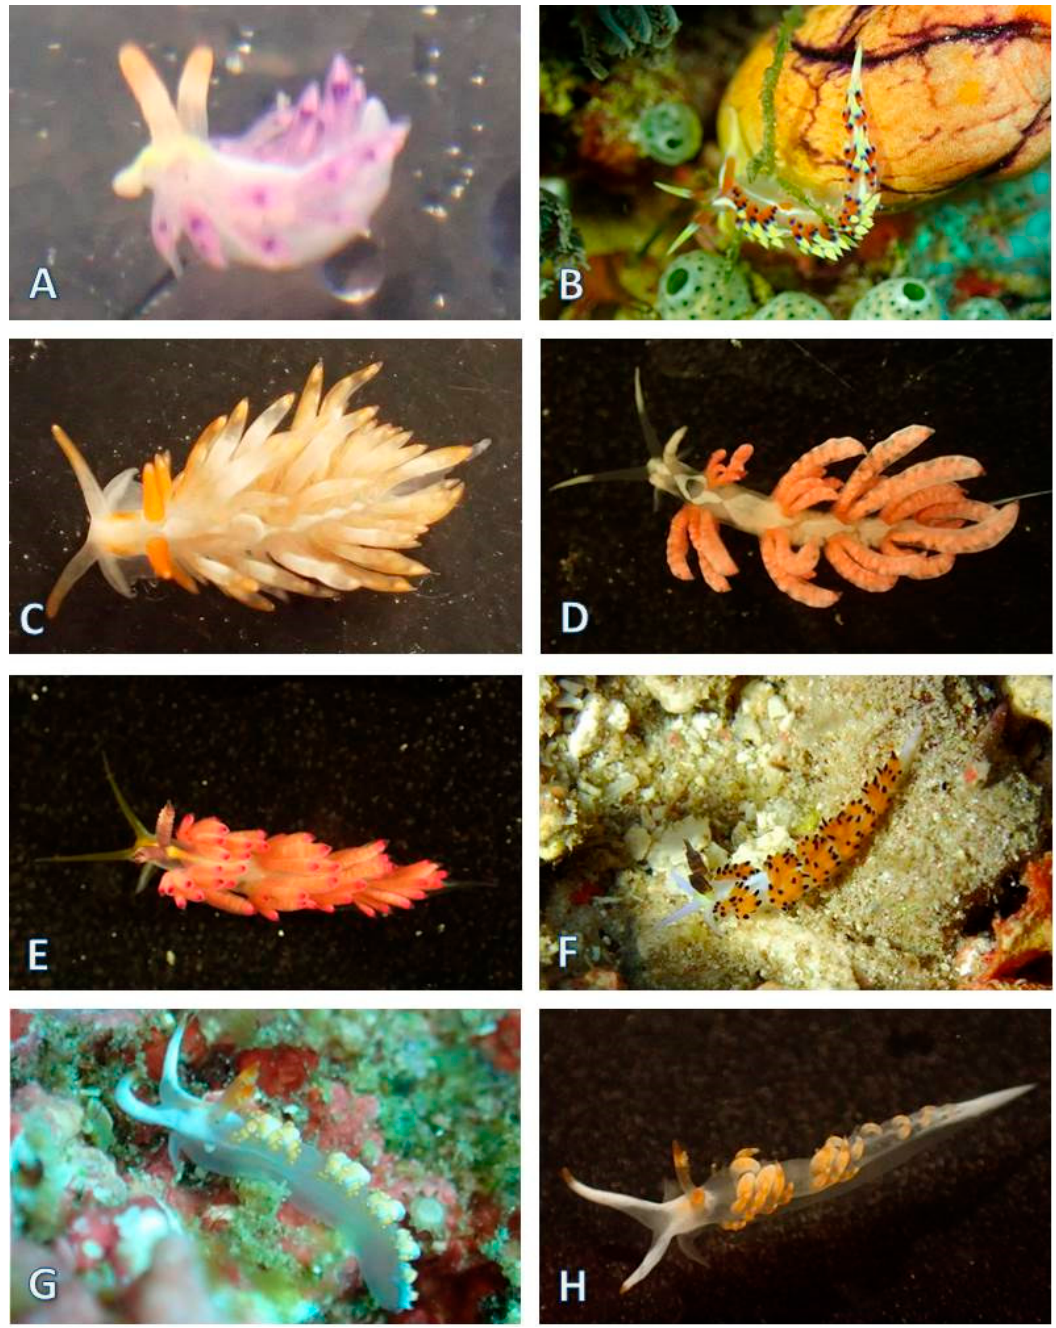
Figure 22. Nudibranchia Cladobranchia: ( A ) Antonietta sp. a, Ansp17Ba-1; ( B ) Caloria indica , Cain18Ba-3; ( C ) Cratena sp. a, Crsp17Ba-1; ( D ) Favorinus japonicas , Faja18Ba-1; ( E ) Favorinus sp. ( Favorinus sp. 1 in Gosliner et al. [24]: 363), Fasp1.18Ba-1; ( F ) Favorinus tsuruganus , Fats17Ba-1; ( G , H ) Moridilla sp. a, Nosp1.17Ba-1, Mojo18Ba-1.